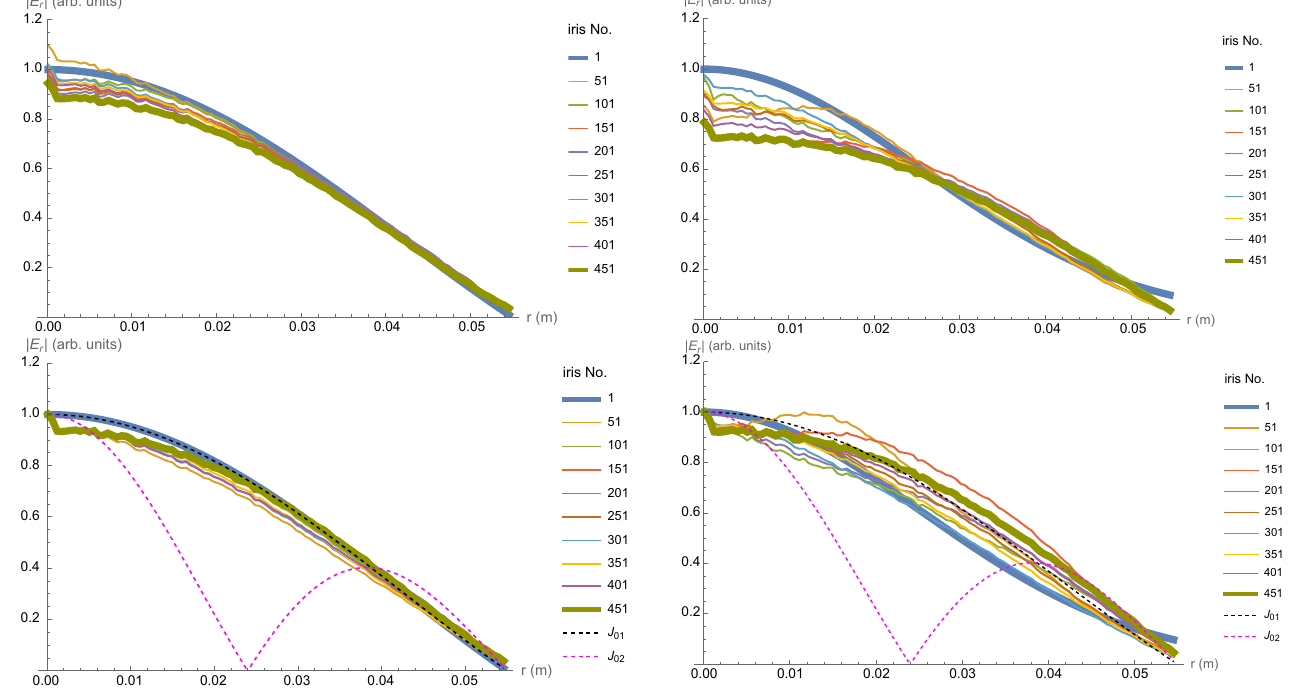
FIG. 12. Transients along the iris line (sampled at the indicated FIG. 11. Transients along (sampled at the indicated irises) the irises) for the backed-off Gaussian excitation case. The plots iris line for the matched J 0 ð 2 . 4 r=a Þ source case. The plots show show the magnitude of the field component E , without (top) and the magnitude of the field component E , without (top) and with r r with (bottom) normalization with respect to the amplitude on the (bottom) normalization with respect to the amplitude on the axis axis r ¼ 0 . Heavy trace lines in the plot highlight the field r ¼ 0 . Heavy trace lines in the plot highlight the field profiles at profiles at the first iris and last iris of the line, while dashed lines the first iris and last iris of the line, while dashed lines highlight highlight the first two eigenmodes of the iris line (denoted the first two eigenmodes of the iris line (denoted J 01 , J 02 ). J 01 , J 02